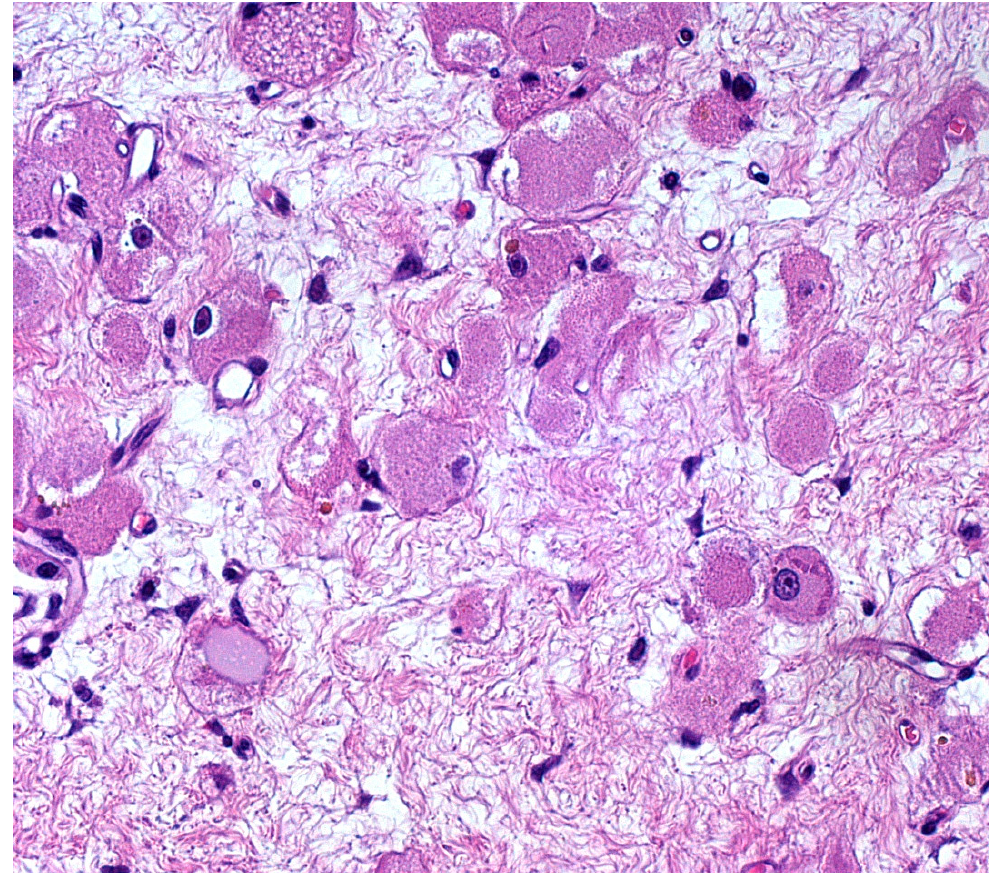
Figure 4. Nuclear atypia was absent to mild. Indeed, the large- to medium-sized tumor cells showed relatively monomorphic, peripherally or centrally located, vesicular nuclei of small to medium size; the chromatin was fine, despite occasional slight variation in nuclear size and shape, with irregularities of nuclear membranes and rare multinucleations. The nucleoli were occasionally evident, but small. Pleomorphism, mitoses and necrosis were absent. The intercellular stroma was almost virtual in the majority of the tumor, but loose connective tissue (no desmoplasia) was found in less-cellular areas (like this one) (Hematoxylin and Eosin, 20×; previously unpublished, original photo).